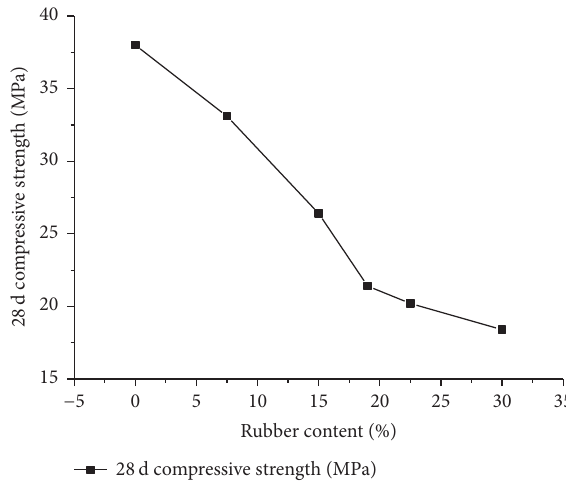
Figure 1: 28 d compressive strength of cement mortar with different amount of 60-mesh rubber